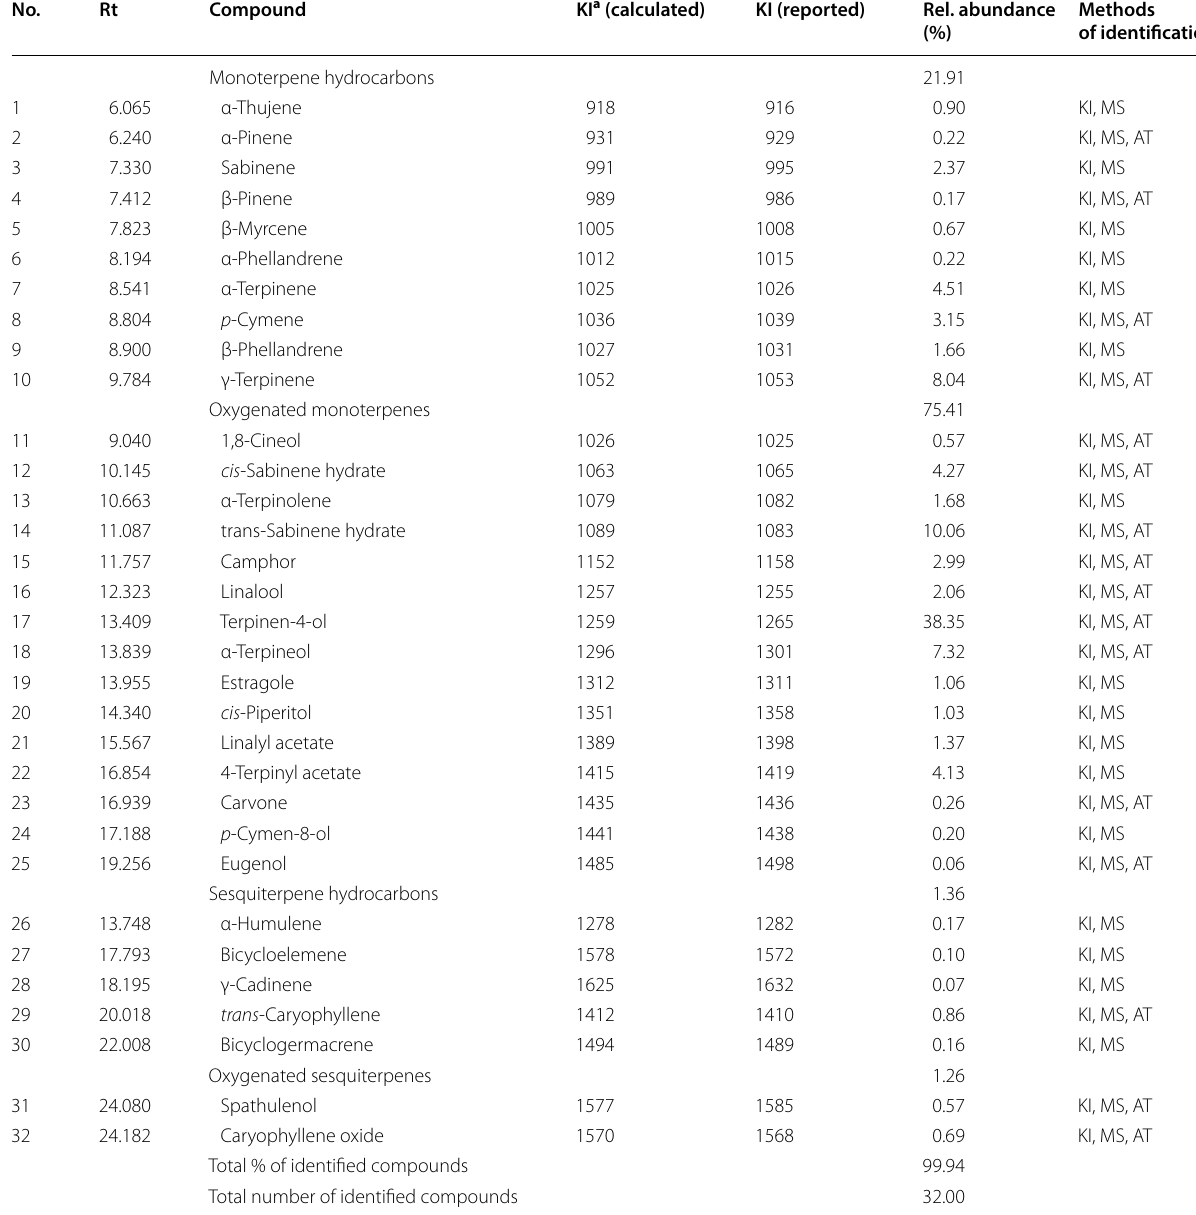
Table 1 Identified constituents in OV EO using GC/MS